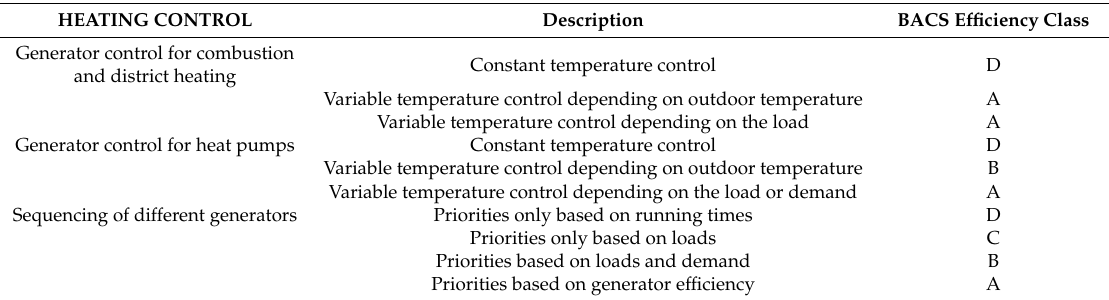
Table 1. The selected BACS control and TBM functions of heating sources/generators.